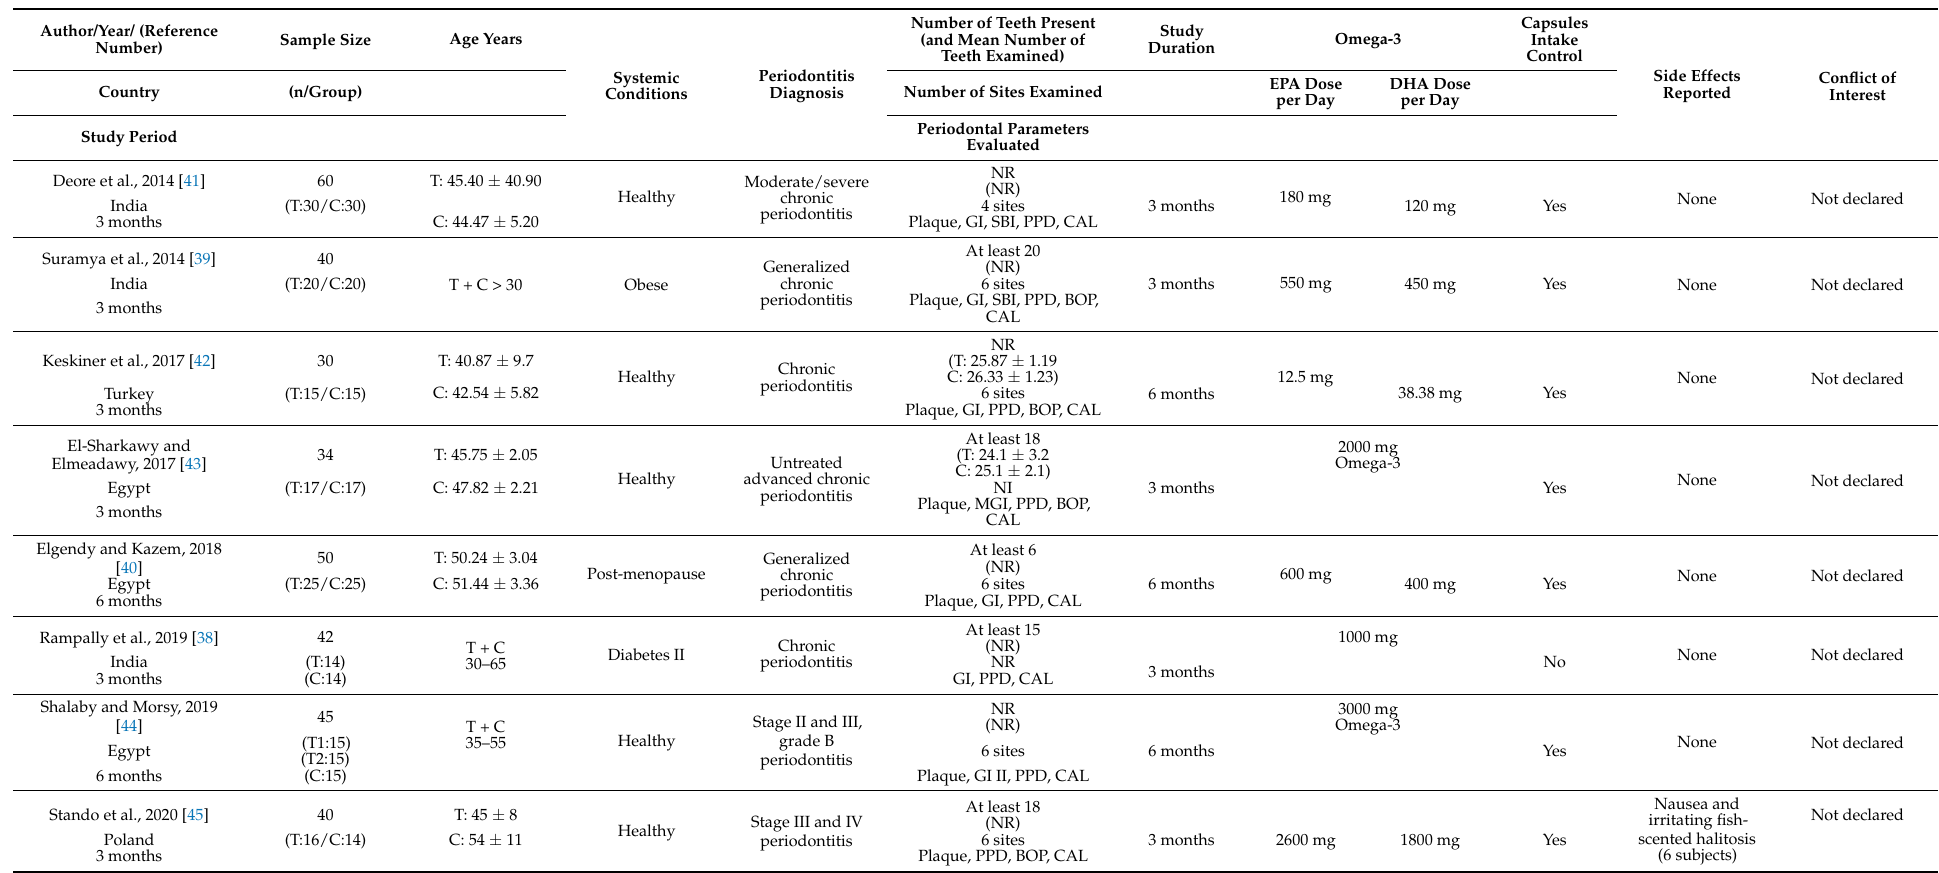
Table 2. Study characteristics of selected